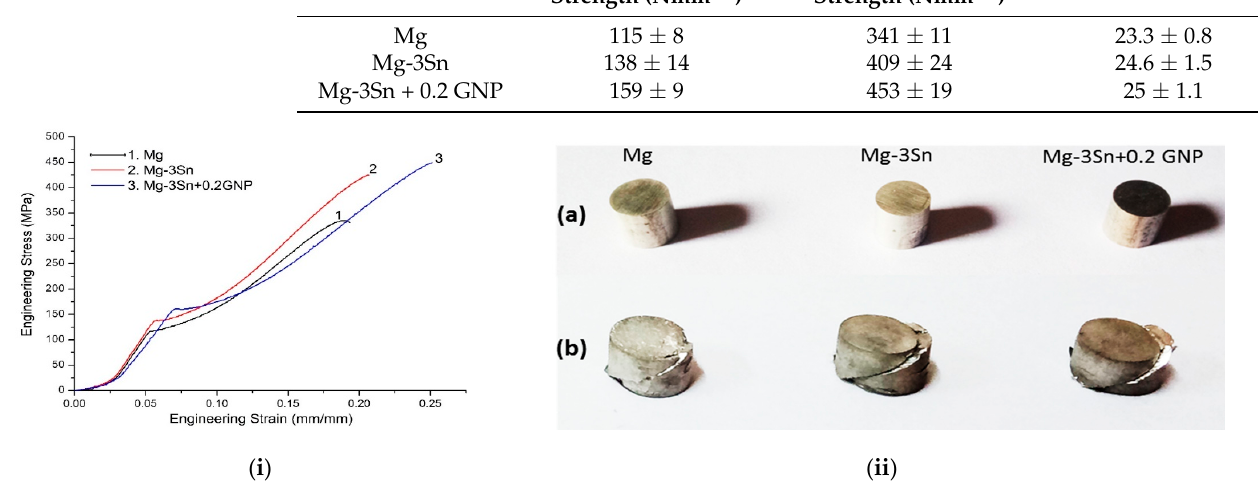
Figure 9. Compressive behavior of pure Mg, Mg-3Sn alloy, and Mg-3Sn + 0.2 GNP composite: ( i ) representative compressive engineering stress–strain curve and ( ii ) corresponding images of undeformed and deformed samples.